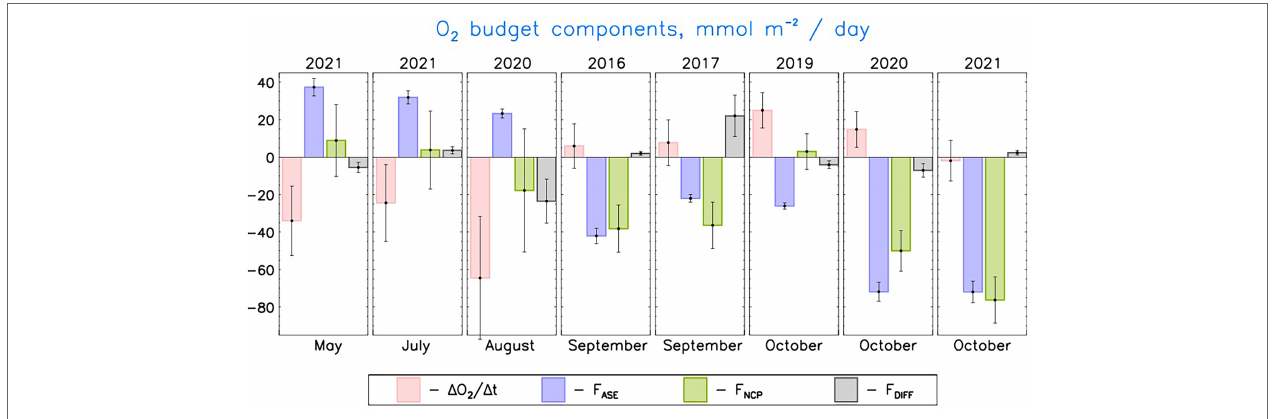
FIGURE 11 | O 2 budget inventories in the surface mixed layer for eight glider surveys. At the bottom of each panel, month identifies time with maximum data coverage during each survey. The order of panels is chosen to follow the seasonal cycle. Estimates of surface fluxes are means based on five parameterizations of gas transfer velocity (Section 3e). Note that negative F ASE results in a positive addition of oxygen to the surface mixed layer; this sign convention is illustrated as follows: May 2021 shows a small positive F NCP (contributing positive to ∆ O 2 in a net negative .Negative F DIFF results in a positive addition of oxygen to the surface mixed layer from the deeper ∆ t